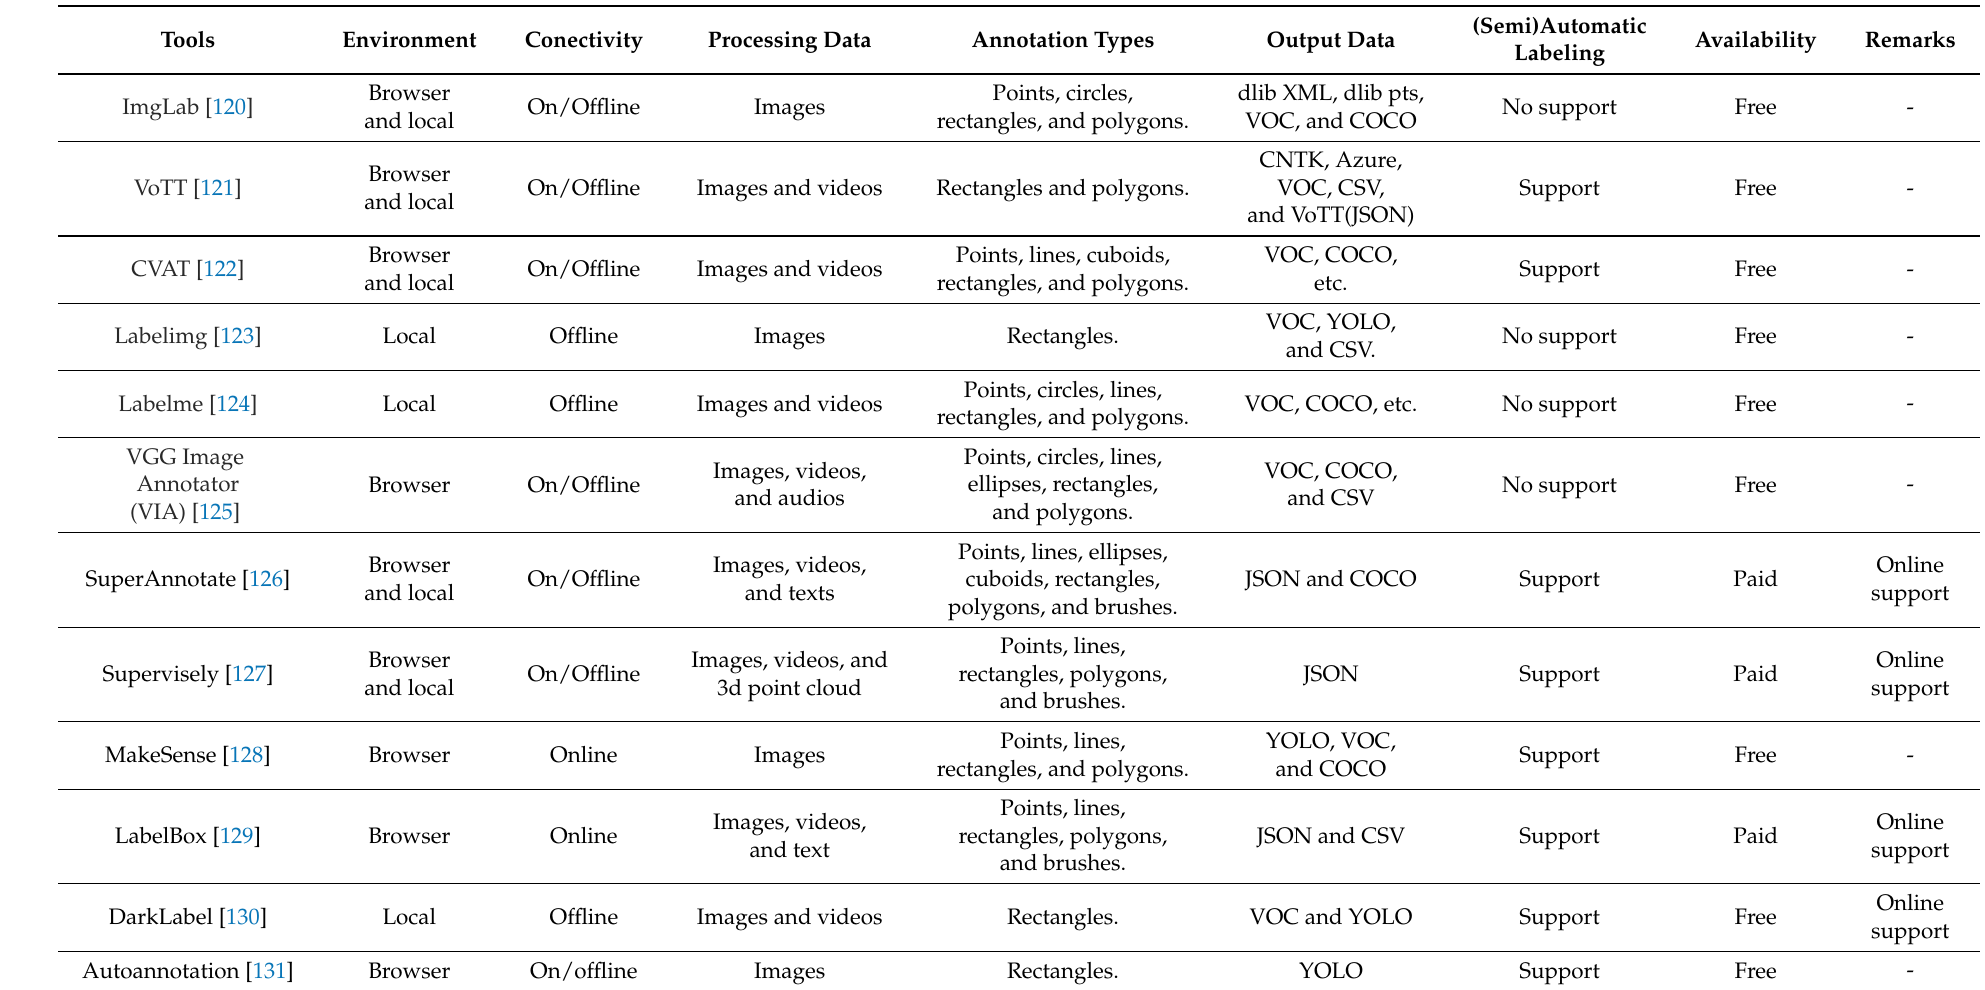
Table 4. Comparison of tools for labeling images and